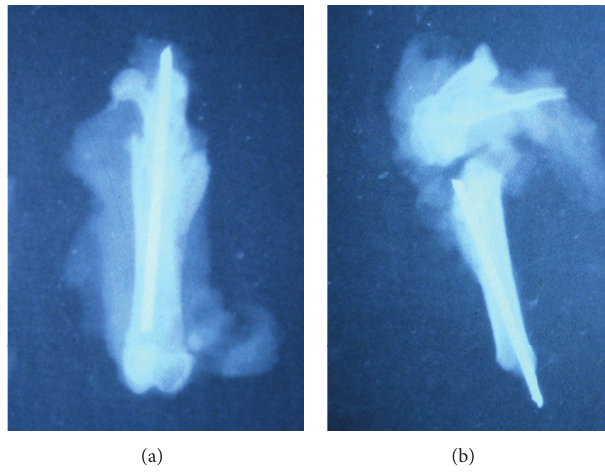
F 4: Examples of X-ray with consolidation and nonunion of fractures. (a) Consolidation fracture of the femur 4 weeks aer osteotomy. (b) Nonunion